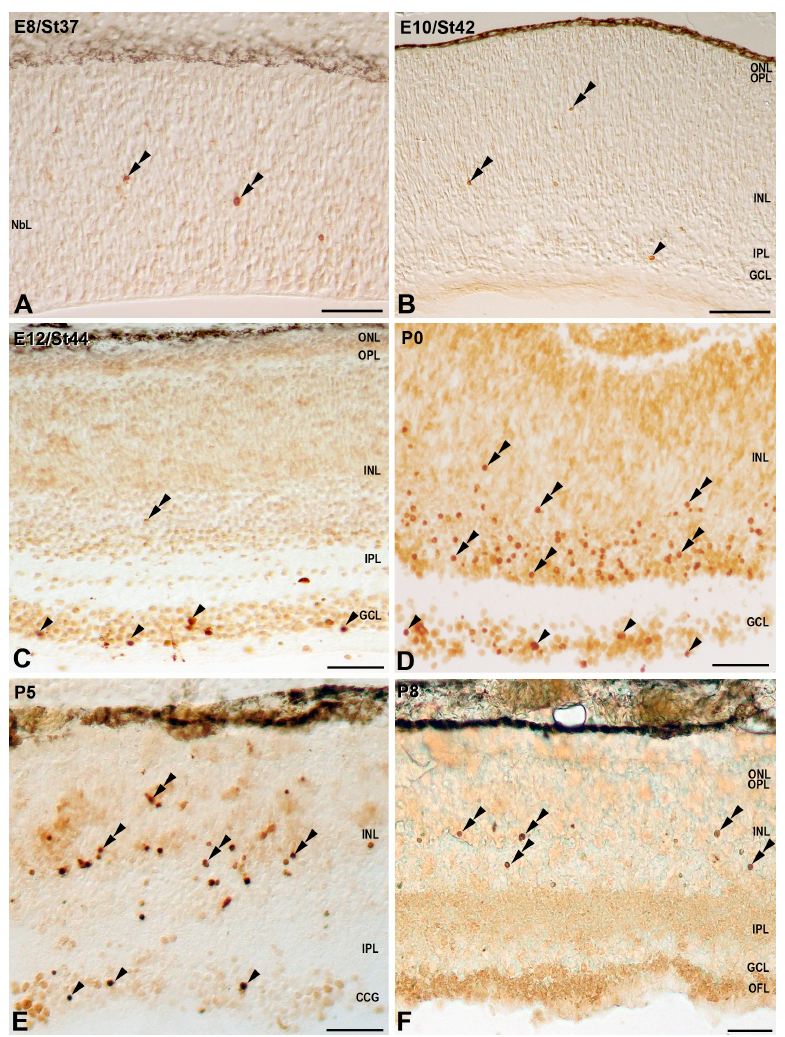
Figure 5. Spatial distribution of TUNEL-positive nuclei in the developing retina of T. guttata . Retinal cryosections of embryos and postnatal specimens were treated in accordance with this histochemical technique. Sparse randomly distributed TUNEL-positive nuclei were detected in the NbL at St37 (double arrowheads in ( A )). At St42, sparse TUNEL-positive nuclei were detected both in the GCL (arrowhead in ( B )) and in the INL (double arrowheads in ( B )). TUNEL-positive nuclei were mainly detected in the GCL at St44 (arrowheads in ( B )), but also in the INL (double arrowhead in ( C )). TUNEL-positive nuclei progressively diminished from P0 to P8 in the GCL (arrowheads in ( D , E )), but they increased markedly from P0 to P5 in the INL (double arrowheads in ( D , E )). At P8, TUNEL-positive nuclei in the INL were less abundant than observed at previous stages (double arrowheads in ( F )). Abbreviations: GCL, ganglion cell layer; INL, inner nuclear layer; IPL, inner plexiform layer; NbL, neuroblastic layer; ONL, outer nuclear layer; OPL, outer plexiform layer. Scale bars: 50 µm.